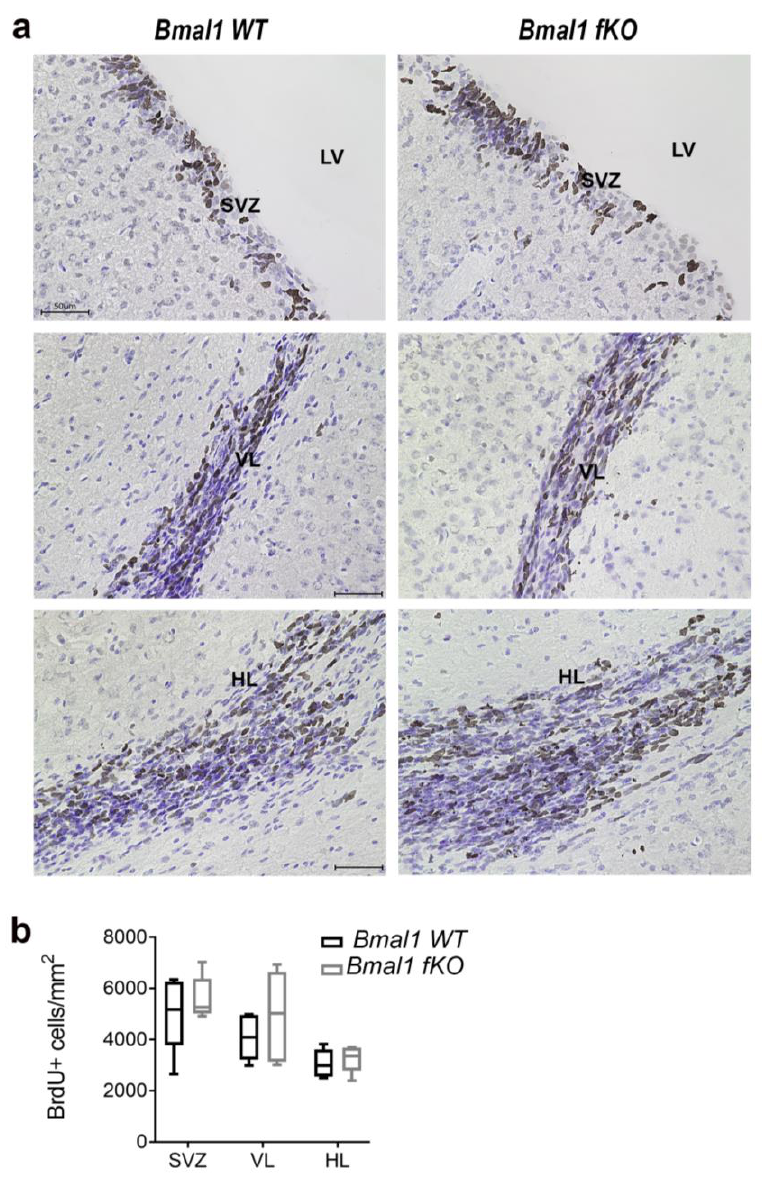
Figure 6. Proliferating cells in the subventricular zone and the rostral migratory stream in Bmal1 fKO mice. ( a ) Representative photomicrograph of BrdU+ cells (brown) and cresyl violet staining (blue) in the subventricular zone (SVZ), the vertical limb of the rostral migratory stream (VL), and the horizontal limb of the rostral migratory stream (HL). Scale bars = 50 µm. LV = lateral ventricle. ( b ) Quantitative analysis of BrdU+ cells in the SVZ, the VL, and the HL. n = 5 mice per genotype. 2.5. Forebrain Specific Bmal1 Deletion does not Affect Migration of NPCs to the OB